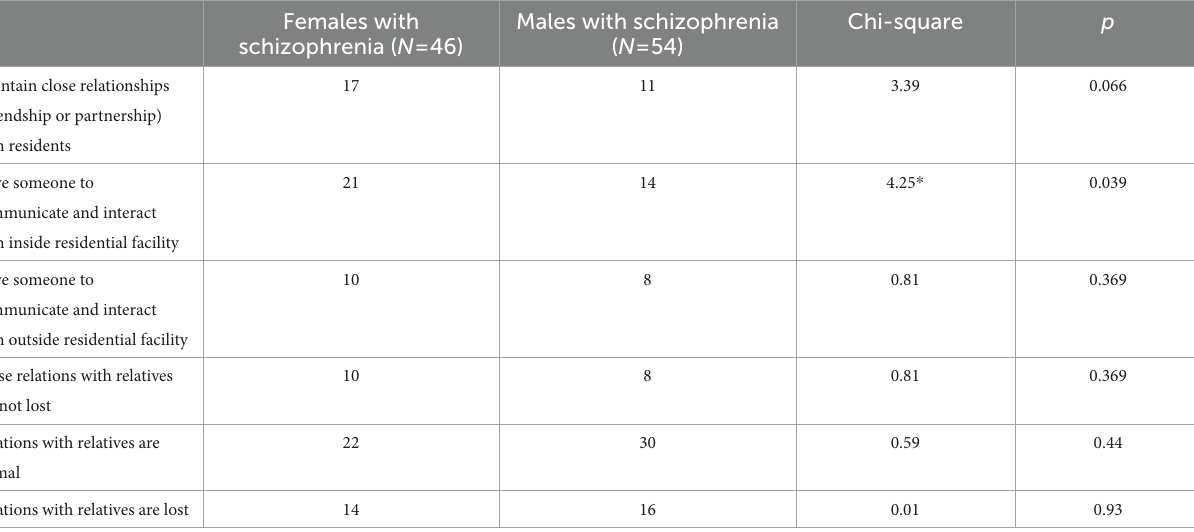
TABLE 5 Interpersonal